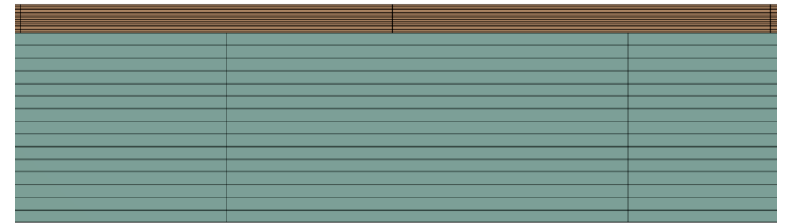
Figure 5. Zoomed-in side view of the membrane zone (orange) and the outflow zone (grey) grid.